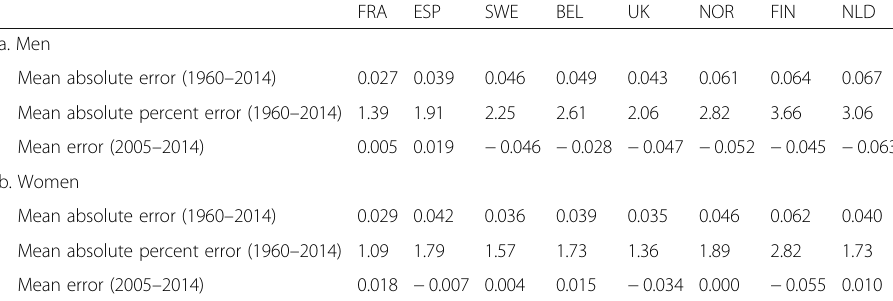
Table 9 Mean absolute (percent) error over the period 1960 – 2014 and mean error over the period 2005 – 2014 of the log death rates limited to age 65 and above of the Lee-Carter forecast estimated over the period 1960 – 2014, men (a) and women (b)